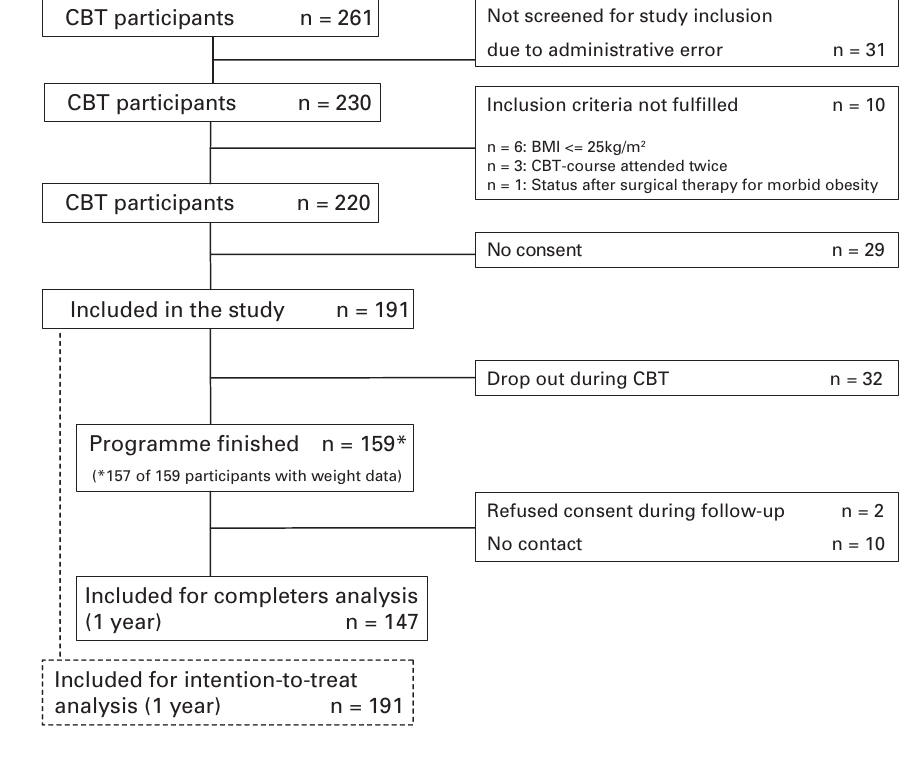
Baseline characteris- tics of